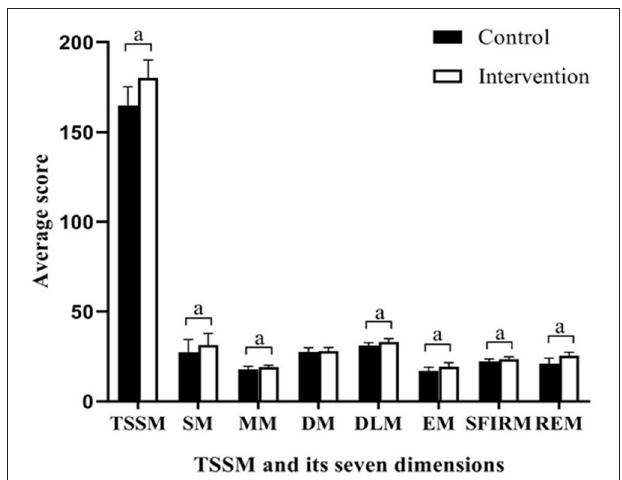
excluding the reduction in the emotion management score in the control group, over time. The total SSMS score and six of the dimension scores, excluding the diet self-management dimension score, in the intervention group were significantly higher than those in the control group at T2 ( t = − 7.891– − 2.815; p ≤ 0.006). The secondary outcome, SPBS scores, is shown in Table 4 and Figure 3 . There was no significant group difference in the baseline scores. Compared to baseline, after the intervention, the SPBS scores all decreased in the two groups. The intervention group showed significantly larger decreases than the control group in the physical burden, emotional burden, and total SPBS scores ( t = 2.102–2.071; p = 0.015–0.041). The economic burden score was not significantly different between the two groups ( t = 1.707; p =